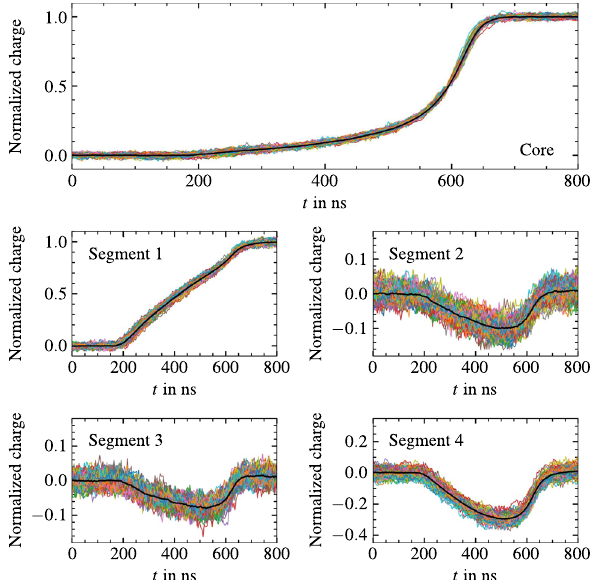
Fig. 13 Individual pulses from events assigned to the interaction point at r = 33 . 5mm, φ = 46 . 1 ◦ and a reconstructed z = ( 20 ± 1 ) mm, using only events with two hits in the pixelated camera that passed the Compton cone validation, see Sect. 4.3, from a 10min Compton Scanner measurement at a detector temperature of 85K. All pulses are time-shifted such that the core pulses are aligned to 50% of their amplitude. Shown in black are the superpulses